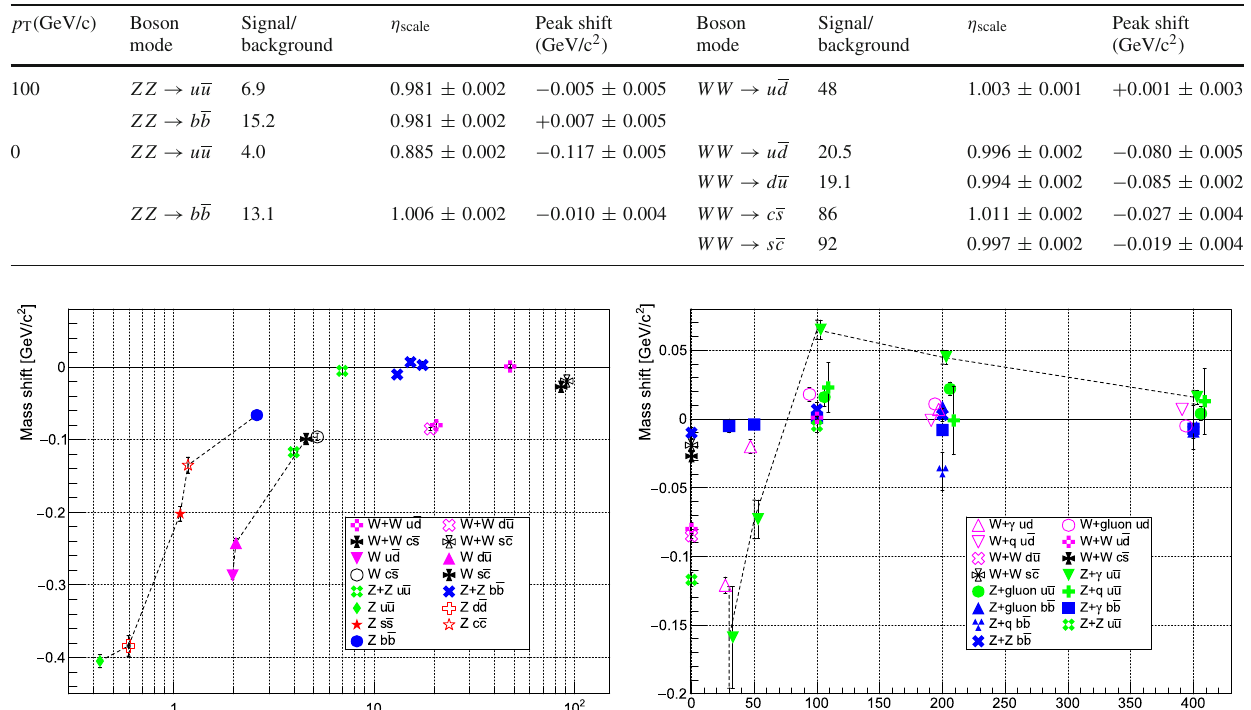
Table 6 Interference effects on the hadronic Z and W boson peaks in qq → V V with one V decaying muonically and the other sepa- rated by final state quark flavour. Signal-to-background is defined at